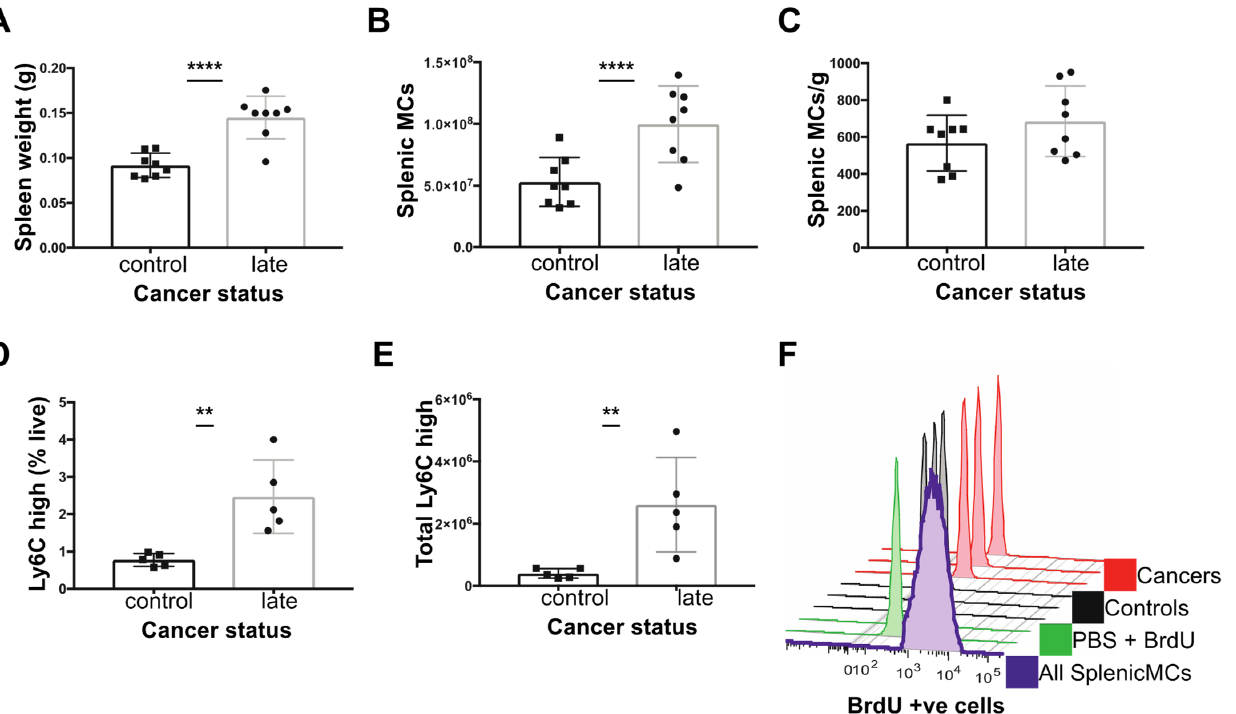
Figure 3. Characterisation of the spleen in C57BL/6 mice with late cancer. ( A ) Splenic weight. ( B ) Total splenic mononuclear cells (MCs; T cells, B cells, monocytes) ( C ) Total splenic MCs (x10 6 ) nor- malised to splenic weight. ( D ) Ly6C high monocytes as % of live cells. ( E ) Total Ly6C high monocytes in spleen. ( F ) Histogram of splenic BrdU levels in: all Splenic MCs in spleen (purple), PBS with no DNase control (green), Ly6C high Mo from controls (n = 3, black) and Ly6C high monocytes from late cancer mice (n = 3, red) 1 h post injection of BrdU. ** p value < 0.01, **** p value < 0.0001, unpaired t- test. Experiments were conducted in duplicates of co-housed littermate groups of n = 6 (3 cancer) and n = 4 (2 cancer).